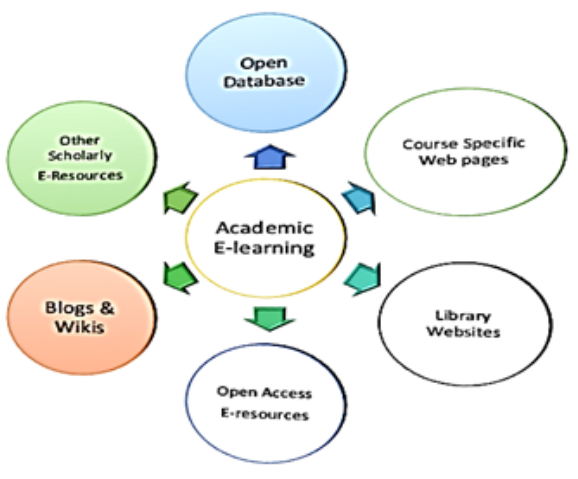
Figure 1. Adopting the ubiquitous e-learning tools